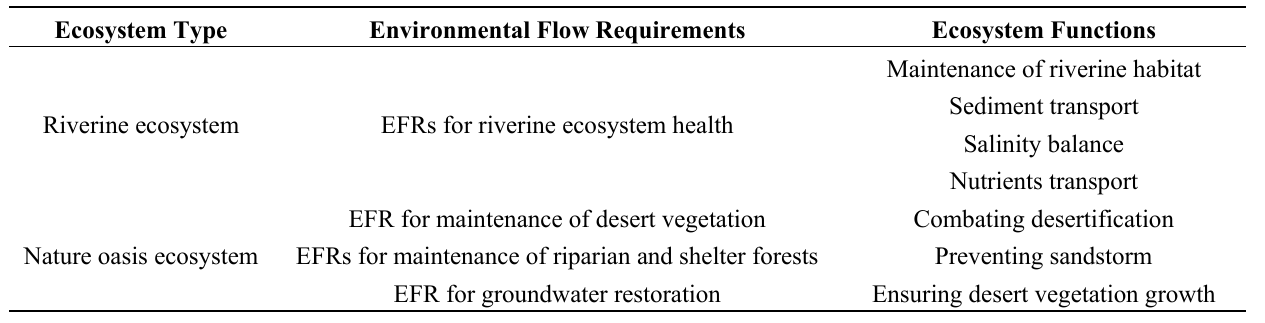
Table 1. Classification of environmental flow requirements (EFRs) in the oasis areas of Tarim